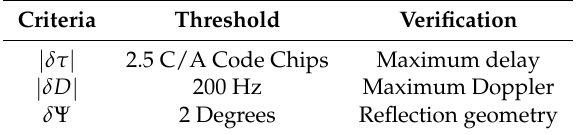
Table 1. Summary of land Geo-location criteria parameters and thresholds used during performance analysis.